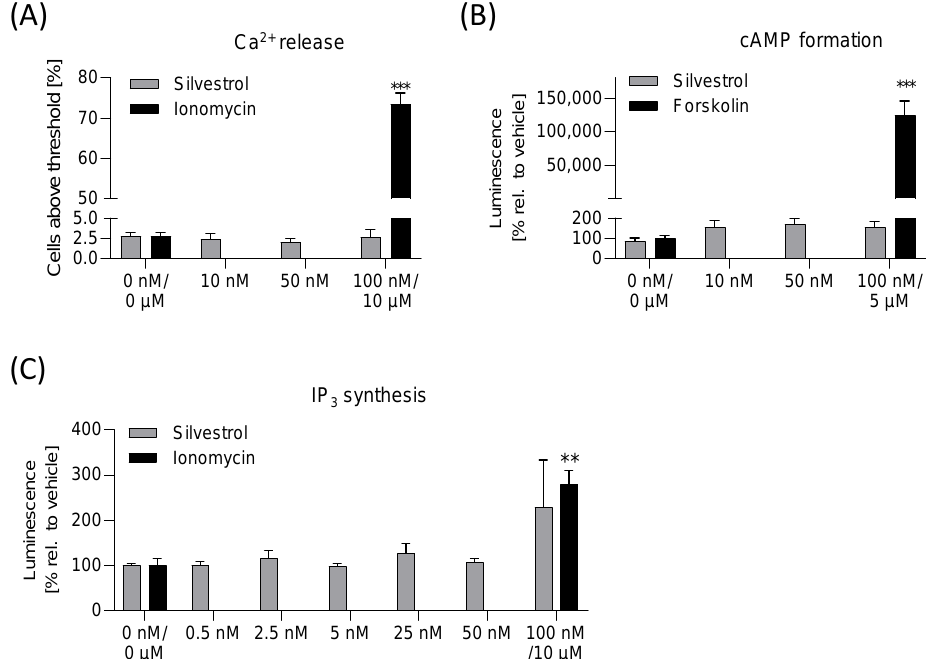
Figure 3. No GPCR-mediated off-target effects of silvestrol. ( A ) For the calcium assay, HEK293T cells were preincubated with Fluo-8-AM. Increasing concentrations of silvestrol, vehicle or 10 µM ionomycin (positive control) were added for 5 min. Data shown are the percentages of cells above the threshold. ( B ) For the cAMP assay, HEK293T cells were transfected with a GloSensor™ luciferase that in presence of cAMP lead to a conformational shift which in turn leads to an activation of the luciferase. The transfected cells were treated with increasing concentrations of silvestrol, vehicle or with 5 µM forskolin (positive control). The silvestrol and forskolin-treated samples were normalized to the respective vehicle control. ( C ) For the IP 3 assay, HEK293T cells transfected with pGloSensor-22F cAMP plasmid were treated with silvestrol or 10 µM ionomycin (positive control). The chemiluminescence signal was detected with a spectrophotometer. The silvestrol- and ionomycin-treated samples were normalized to the respective vehicle control. The experiments were performed in biological triplicates. Data are expressed as mean ± SEM. For statistical analysis of the positive controls an unpaired t-test was used. ** p < 0.01, *** p < 0.001 indicate significant differences between positive controls and vehicle samples.